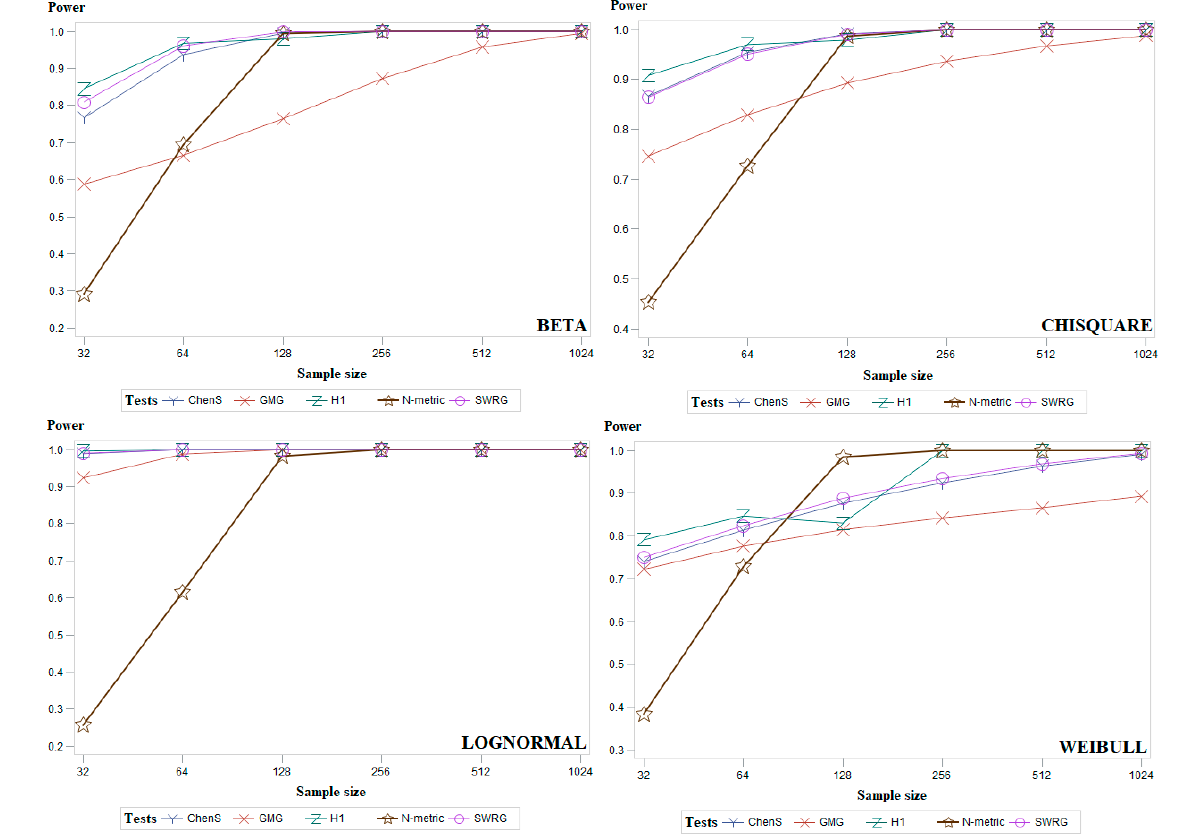
Figure A2. Average empirical power results for the examined sample sizes for the groups of asymmetric distributions of five powerful goodness-of-fit tests.